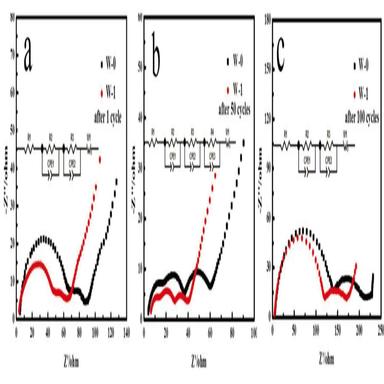
EIS plots of W-0 and W-1 after (a) 1st, (b) 50 cycles and (c)100 cycles.